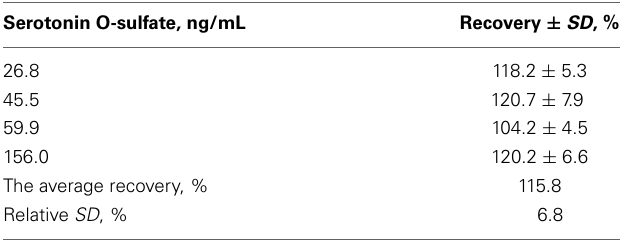
Table 6 | Concentrations of plasma 5-HT-SO4 obtained from the Pilot study